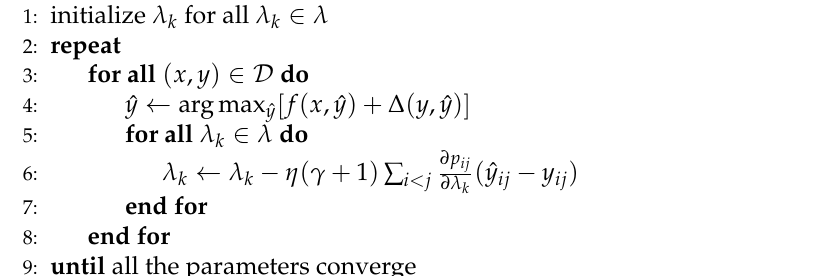
Algorithm 1 The stochastic subgradient descent algorithm for structured support vector machines (SSVMs); η > 0 is the predefined learning